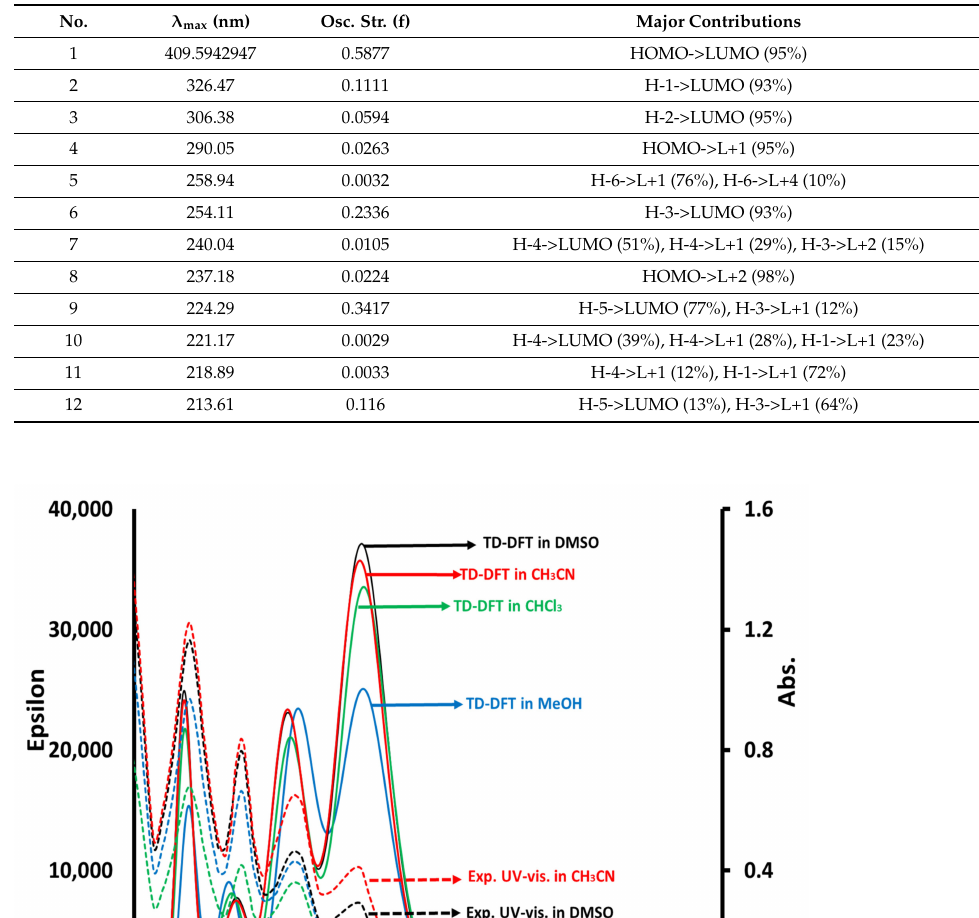
Table 6. CAM-TD-DFT computations parameters.